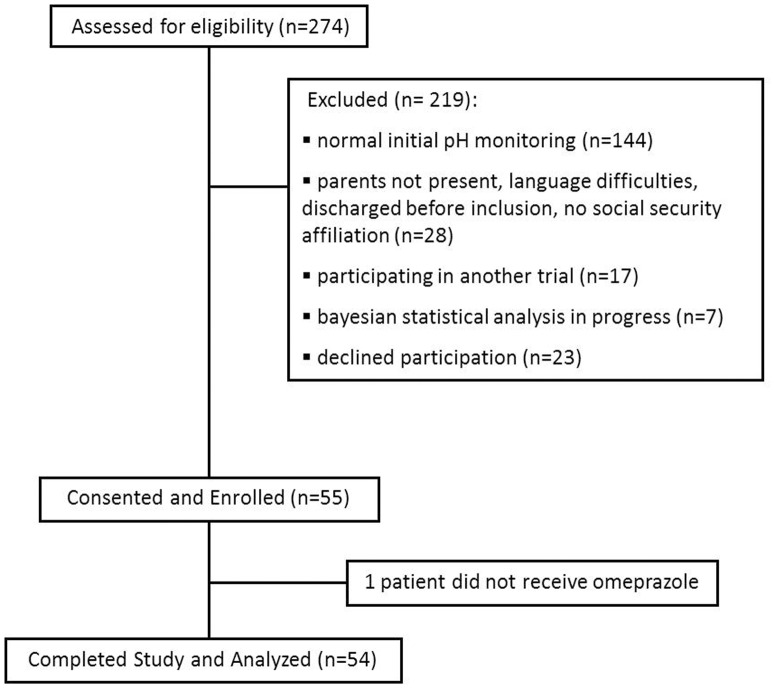
Flow chart of patients.